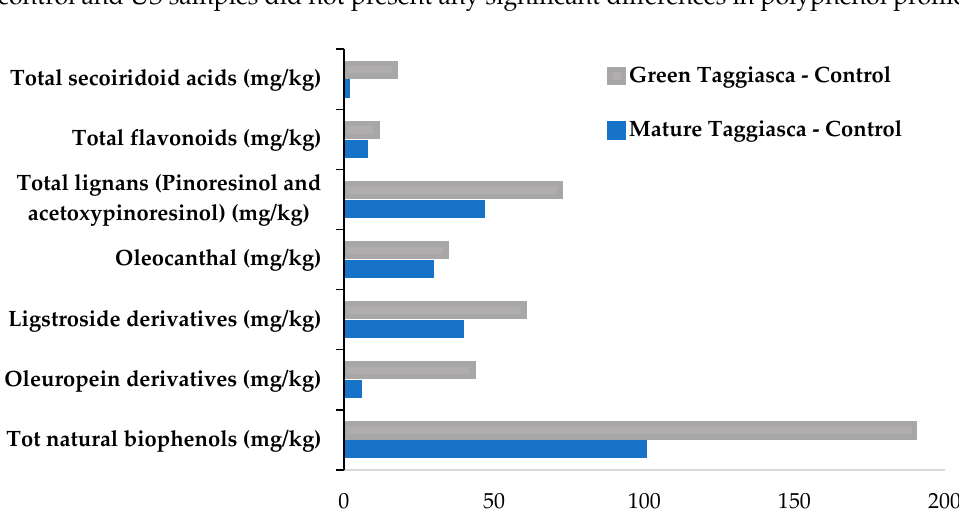
Figure A3. Total biophenols and their composition according to Taggiasca ripening.